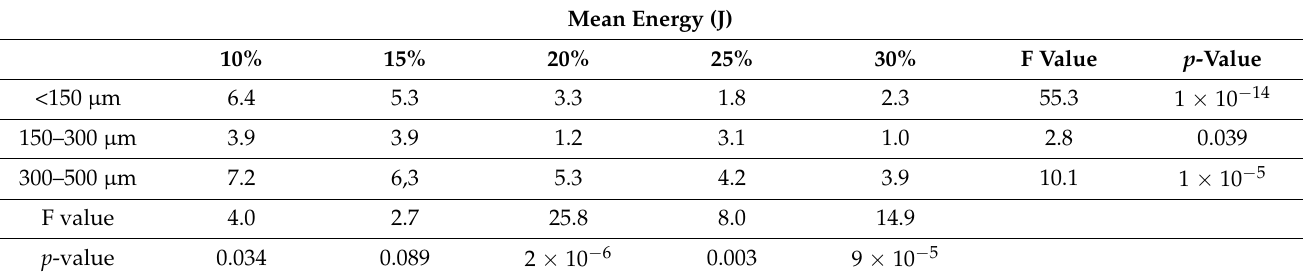
Table 8. One-way ANOVA for comparison of the population means regarding the energy at maxi- mum